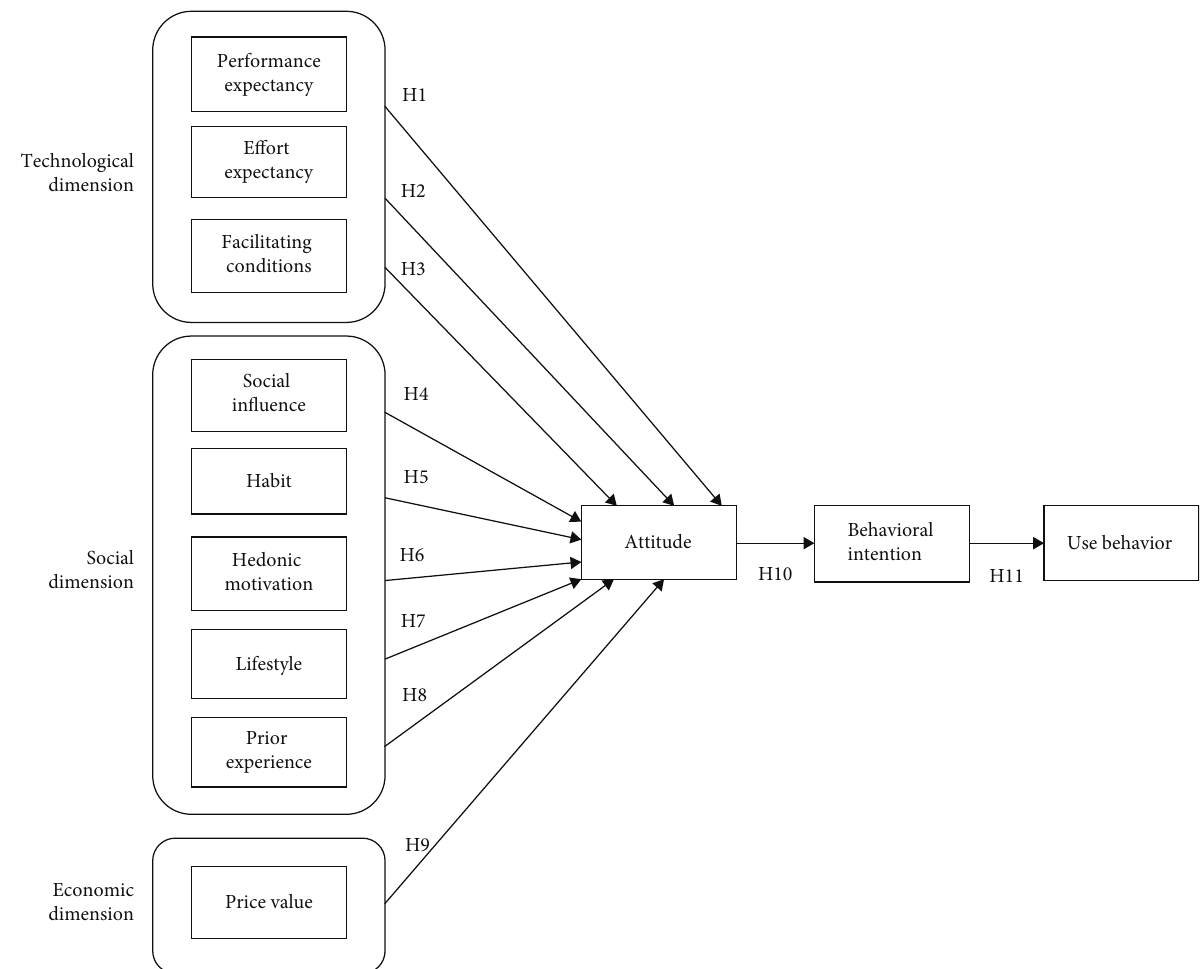
Figure 1: Proposed research